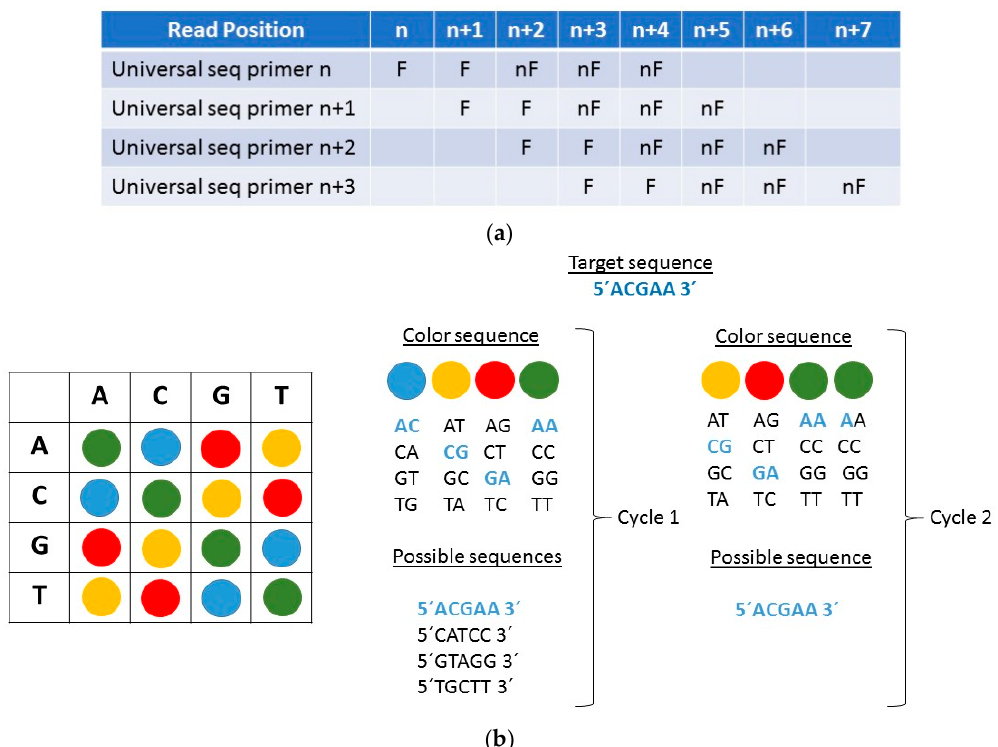
Figure 7. ( a ) Use of the color-space technique in determining the order of nucleotides by sequential ligation of fluorescent probes. F: Fluorescent. nF: non-fluorescent; ( b ) Assignment of colors to nucleotide pairs in sequencing by oligonucleotide ligation and detection.